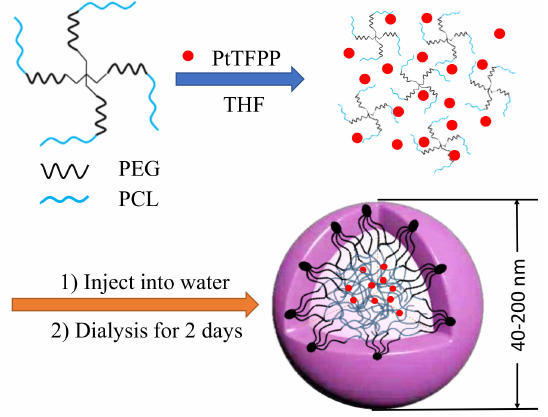
Figure 2. Preparation of platinum(II)-5,10,15,20-tetrakis-(2,3,4,5,6-penta-fluorophenyl)-porphyrin (PtTFPP) encapsulated micelles.